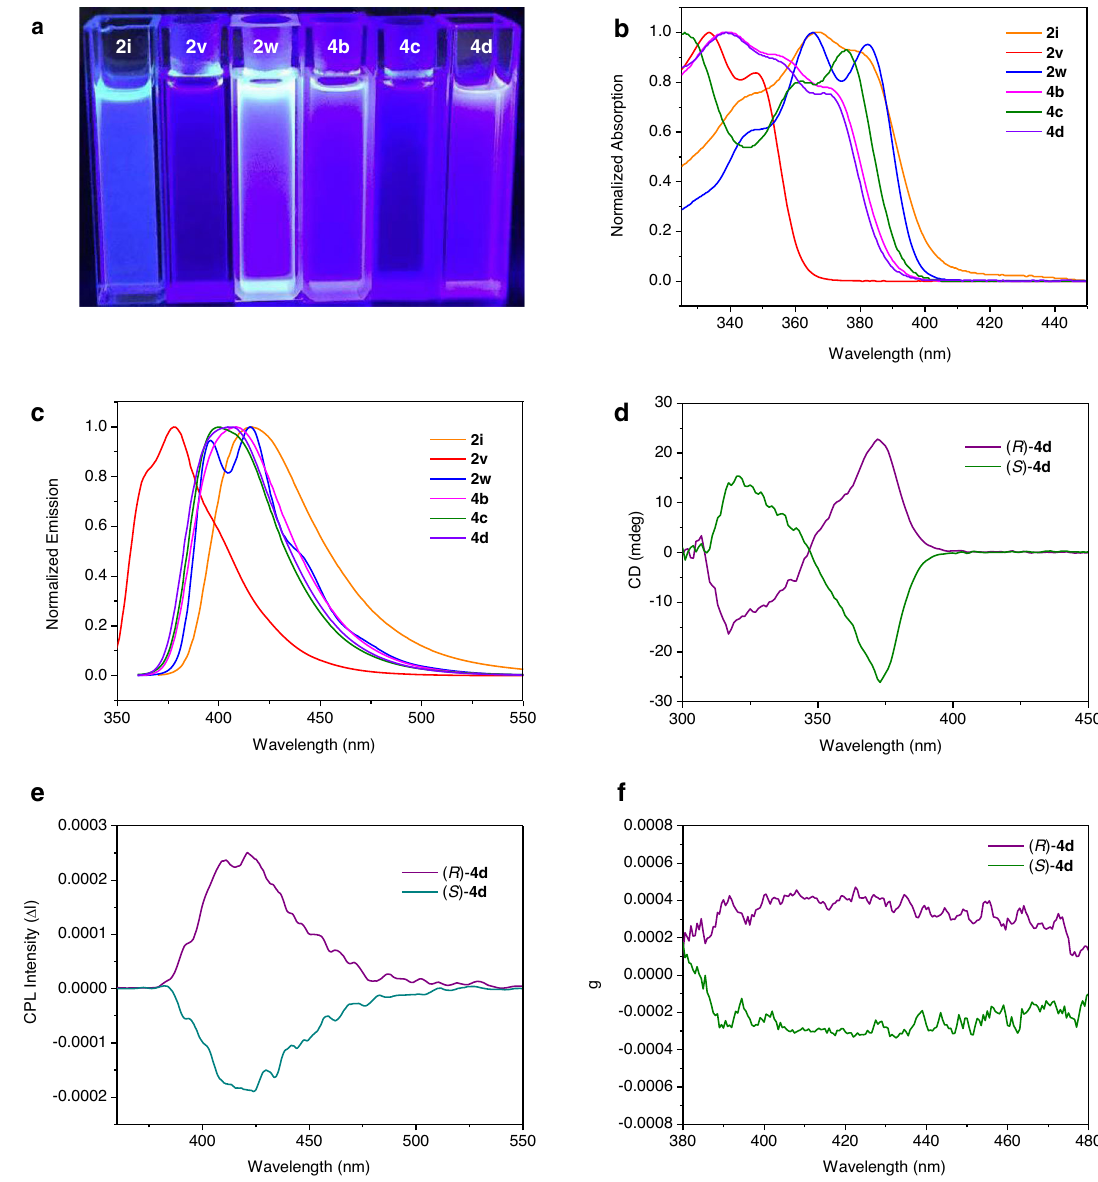
Fig. 6 Photophysical properties investigations. a Fluorescence images of selected silicon-bridged heterocycles ( λ ex = 365 nm). b Absorption spectra of selected silicon-bridged heterocycles in CHCl 3 (10 − 5 M). c Emission spectra of selected silicon-bridged heterocycles in CHCl 3 (10 − 5 M). d CD (circular dichroism) spectra of compound ( R )- 4d (purple line, 91% ee ) and ( S )- 4d (green line, 88% ee ) in CHCl 3 (2.0 × 10 − 4 M) at room temperature. e CPL (circular polarized luminescence) spectra of compound ( R )- 4d (purple line, 91% ee ) and ( S )- 4d (green line, 88% ee ) in CHCl 3 (2.0 × 10 − 3 M) at room temperature, excited at 339 nm. f g lum (Luminescence dissymmetry factor) values-wavelength curve for ( R )- 4d (purple line, 91% ee ) and ( S )- 4d (green line, 88% ee